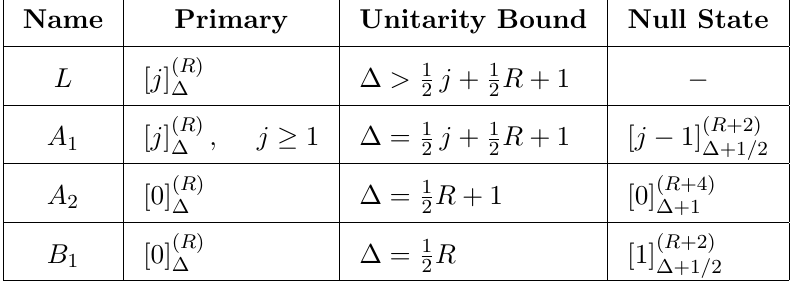
Table 5 . Shortening conditions in three-dimensional N = 3